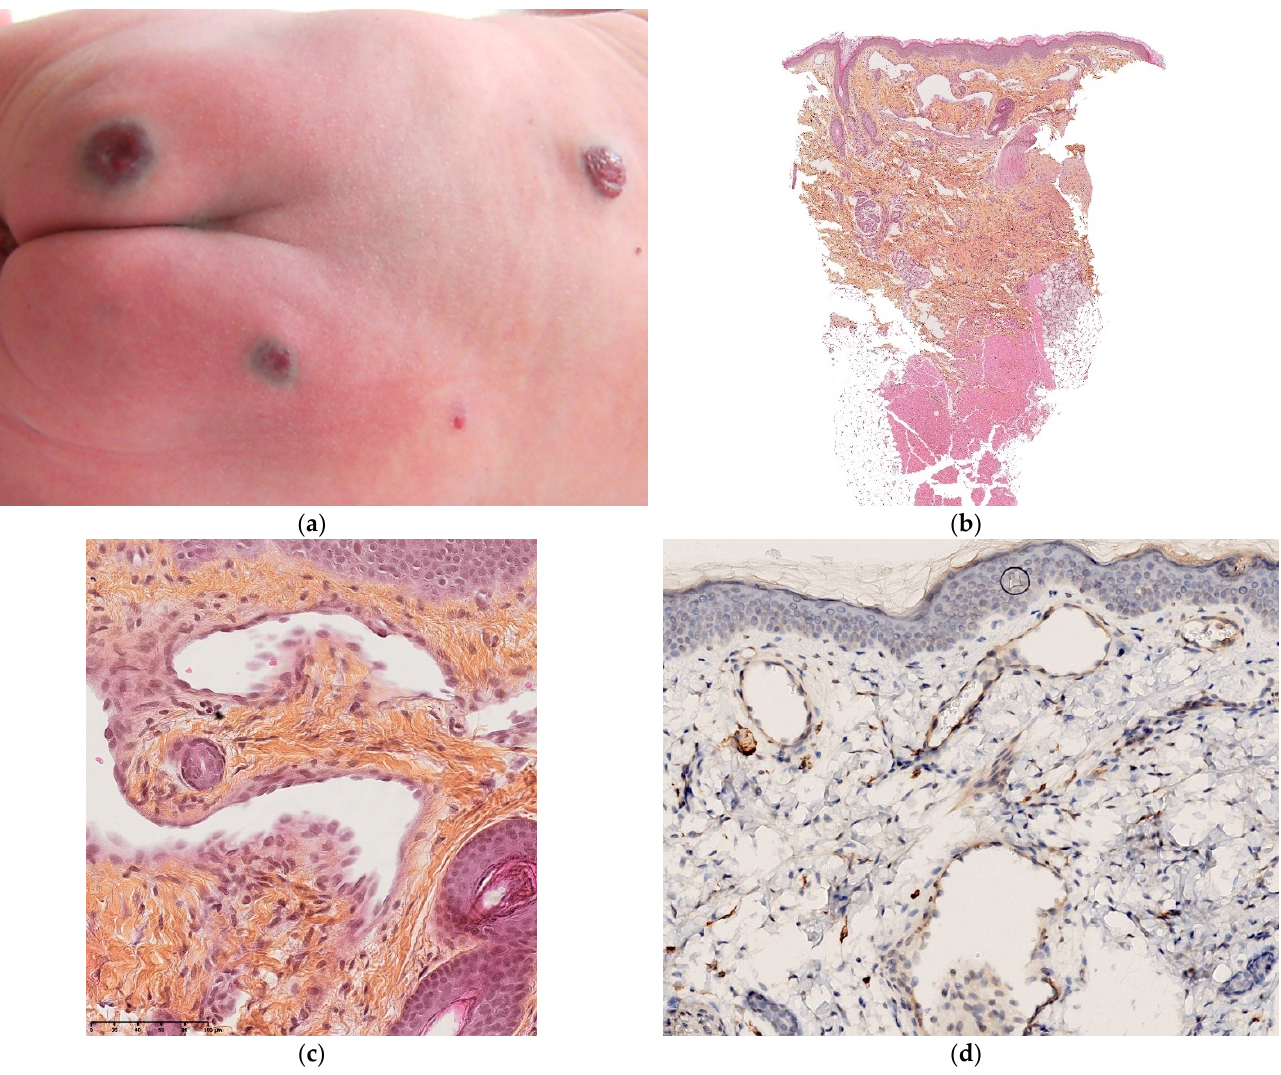
Figure 13. Multifocal lymphangiomatosis with thrombocytopenia. ( a ) Red-brown papules and plaques (by courtesy C Droitcourt). ( b ) 2.5× Thin-walled vascular channels dissecting the superficial and mid-dermis. ( c ) 4× These vessels are lined by endothelial cells with a plump, sometimes hobnail, nucleus. ( d ) These cells are positive for Lyve 1.